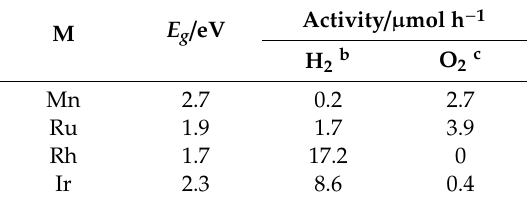
Table 1. Photocatalytic activities of SrTiO 3 :M(0.5%) for H 2 and O 2 evolution from the aqueous solution containing sacrificial reagents under visible light irradiation a . Reprinted with permission from Konta, R.; Ishii, T.; Kato, H.; Kudo, A. Photocatalytic activities of noble metal ion doped SrTiO 3 under visible light irradiation. J. Phys. Chem. B 2004, 108, 8992–8995. Copyright 2004 American Chemical Society [75]. Activity / µ mol h − M E g / eV